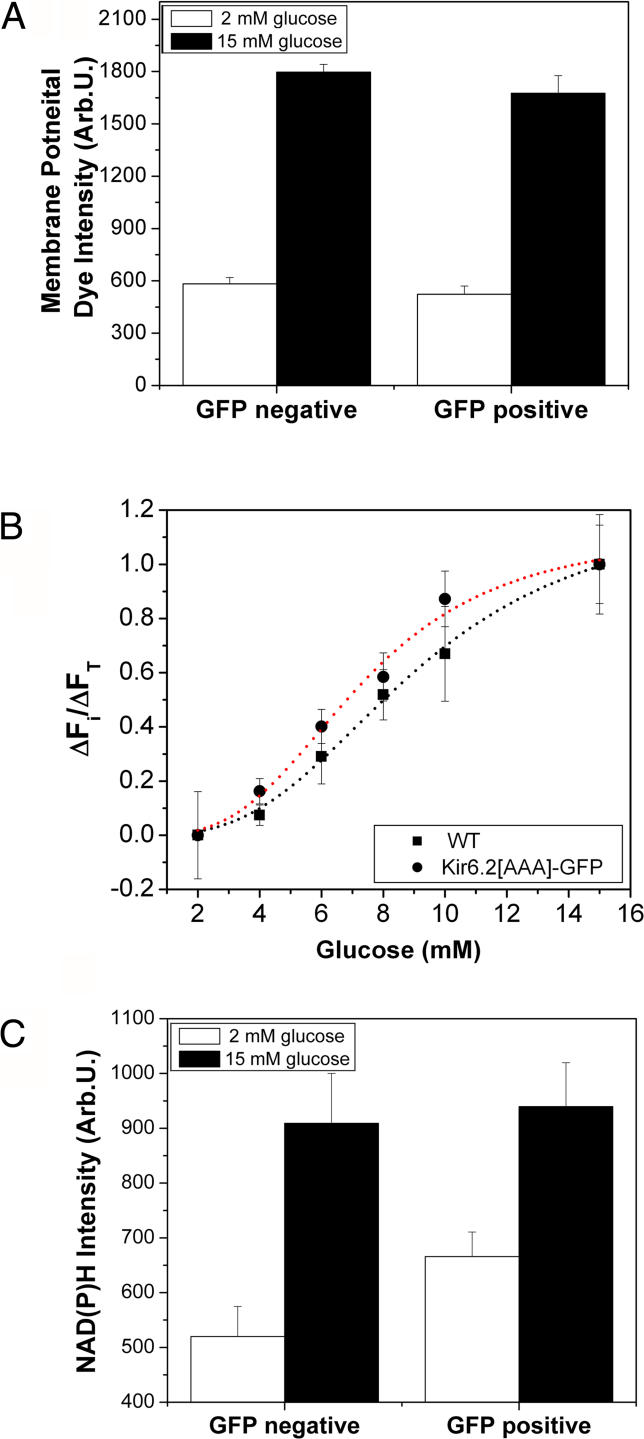
Membrane Potential and Metabolic Response of Kir6.2[AAA] Islets and Cells(A) The membrane potential of GFP-positive and -negative cells within a Kir6.2[AAA] islet. Islets were bathed in 500 nM of membrane potential dye (DiSBAC2(3)) (n = 4). This oxanol dye enters cells in a membrane potential–dependent manner with increasing intensity as a cell becomes depolarized, and is spectrally distinct from GFP. The GFP-positive and -negative cells showed similar intensity (membrane potential) at 2 and 15 mM glucose stimulation, and had responses consistent with the responses observed in WT islets (data not shown).(B) The NAD(P)H glucose-dose response of WT (n = 9) and Kir6.2[AAA]-GFP (n = 10) islets. Device-trapped islets were treated to the indicated glucose concentrations for more than 5 min prior to image collection. The normalized change in NAD(P)H fluorescence intensity (ΔF/ΔFT) is plotted versus glucose stimulation. The black and red dotted lines are the data fitted to a Hill equation with Km values of 9.0 ± 0.7 and 7.6 ± 0.7 mM for the WT and Kir6.2[AAA] islets, respectively.(C) The NAD(P)H responses of dispersed GFP-negative and -positive Kir6.2[AAA] cells. The cells were incubated in 2 mM glucose (open bars) prior to incubation for 5–10 min with 15 mM glucose (closed bars). GFP fluorescence was used for the distinction as GFP negative or positive. NAD(P)H-intensity measures were taken from cells in four fields of view from nine separate dishes of Kir6.2[AAA] dispersed cells (n = 9).